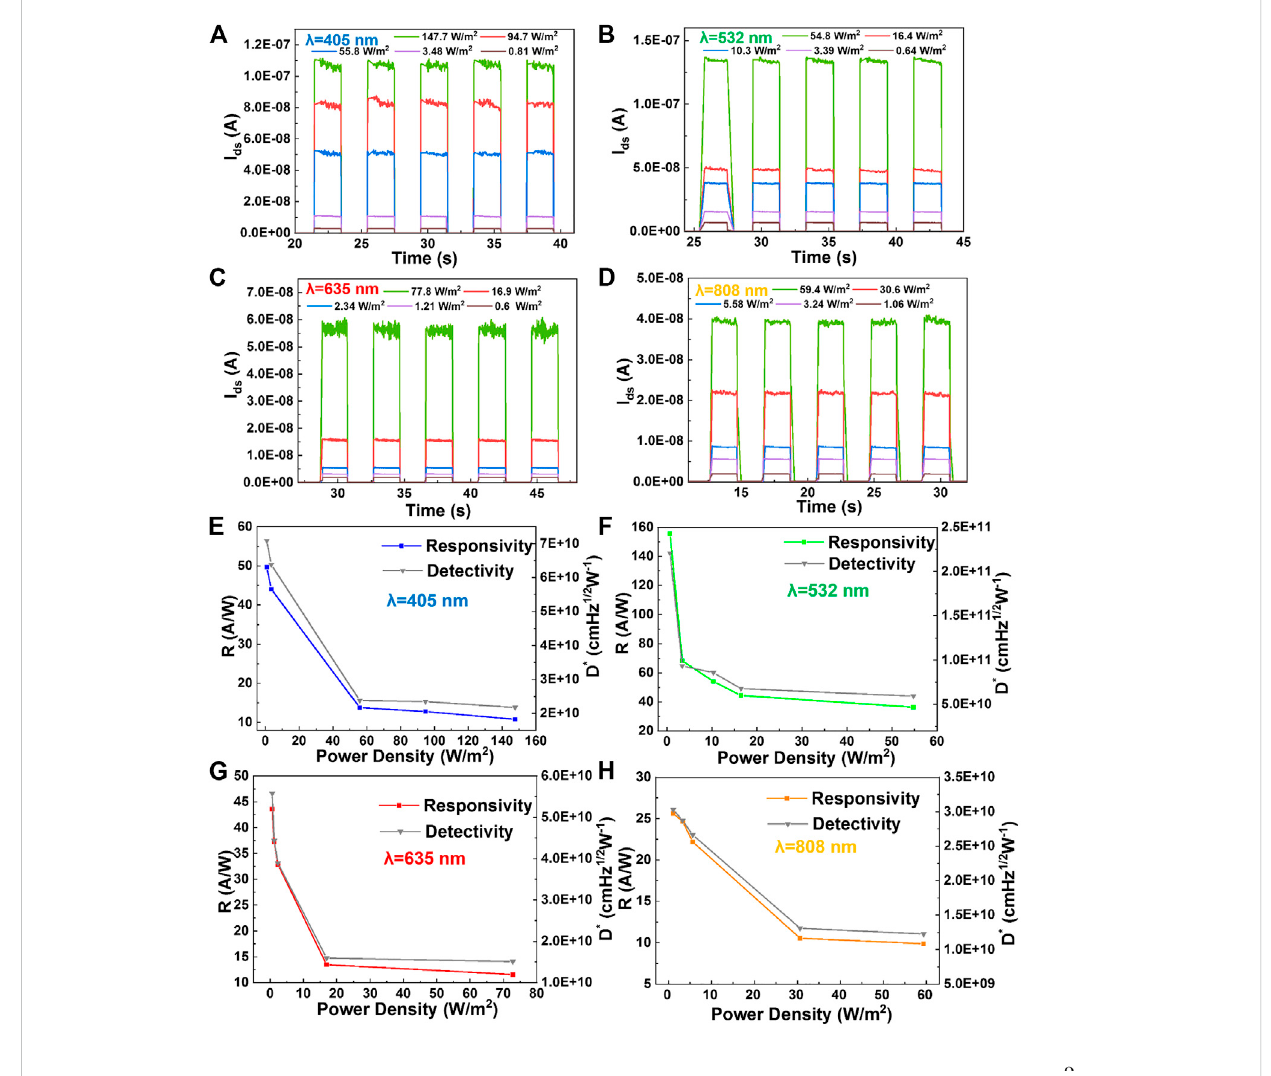
FIGURE 4 The photo response of the MnSe/WSe 2 heterojunction at V ds = 5 V and V g = 0 V under the irradiation of (A) 405 nm, (B) 532 nm, (C) 635 nm and (D) 808 nm laser, respectively, with different light power intensities. The light-power-dependent responsivity and detectivity under the irradiation of (E) 405 nm, (F) 532 nm, (G) 635 nm and (H) 808 nm laser,